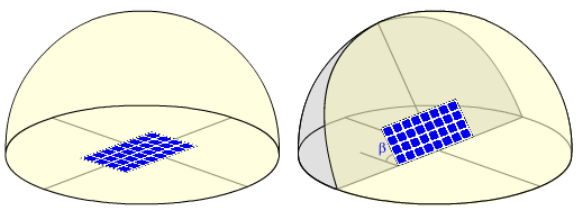
Figure 2: Visibility of Sky Dome (Honsberg & Bowden,